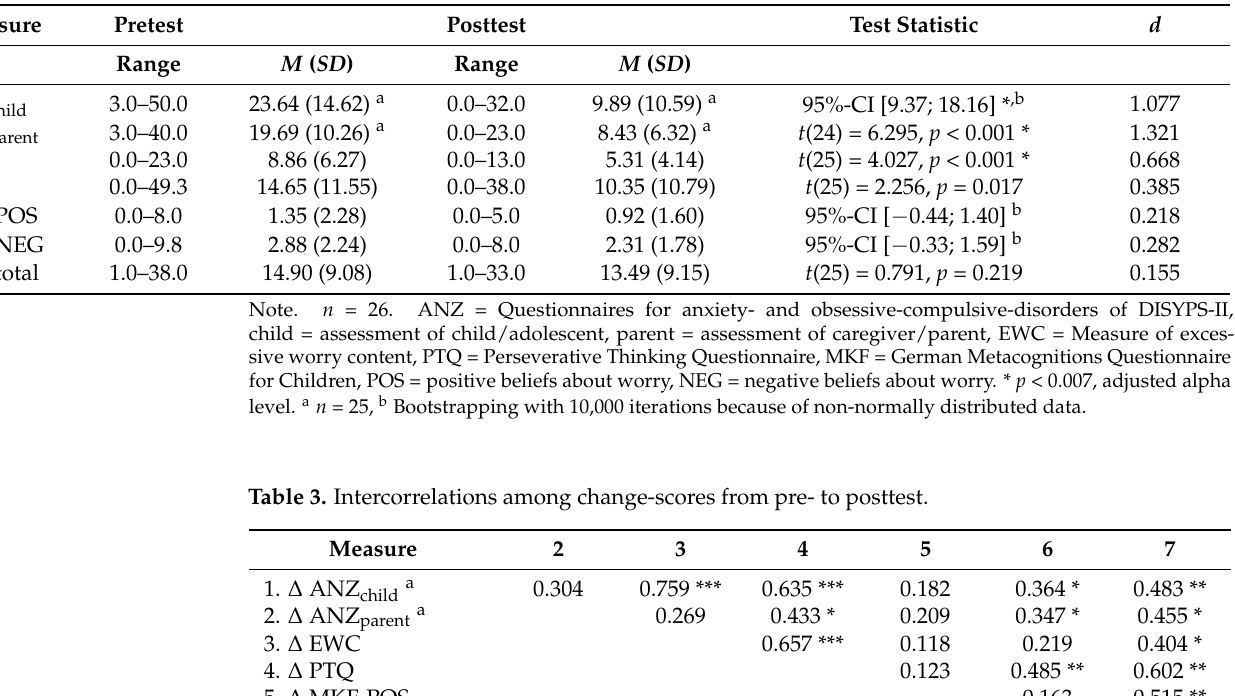
Table 2. Means (standard divisions) and test-statistic on anxiety, metacognitions and repetitive thinking at pretest and posttest.